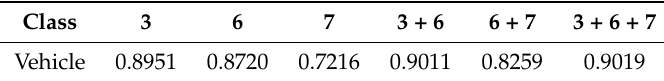
Table 4. The precision of three medial layers for the satellite dataset.